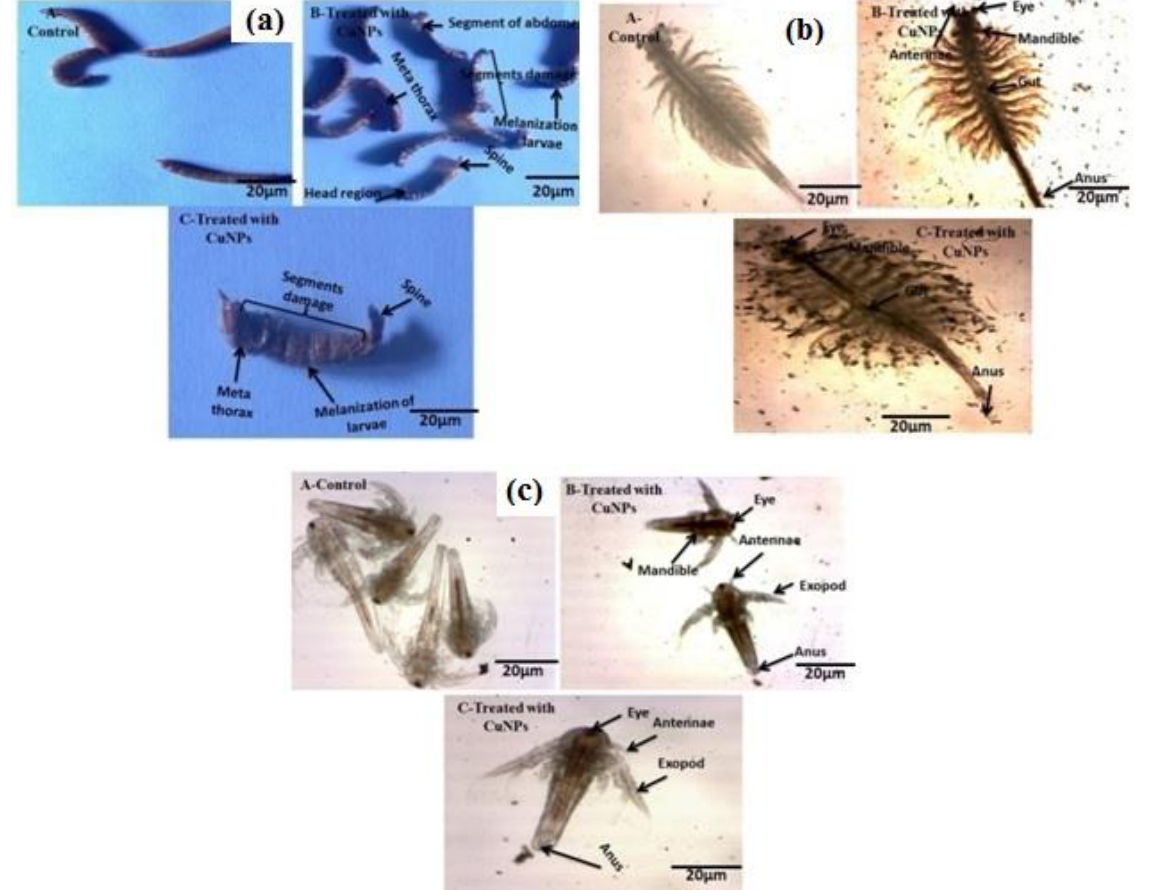
Figure 5. Effect of green copper nano-pesticide synthesized from M . robertsii against 4th instar larvae of T . molitor , A . salina and A . nauplii : ( a ) T . molitor , ( b ) A . salina , ( c ) A . nauplii at 24 h after treatment.